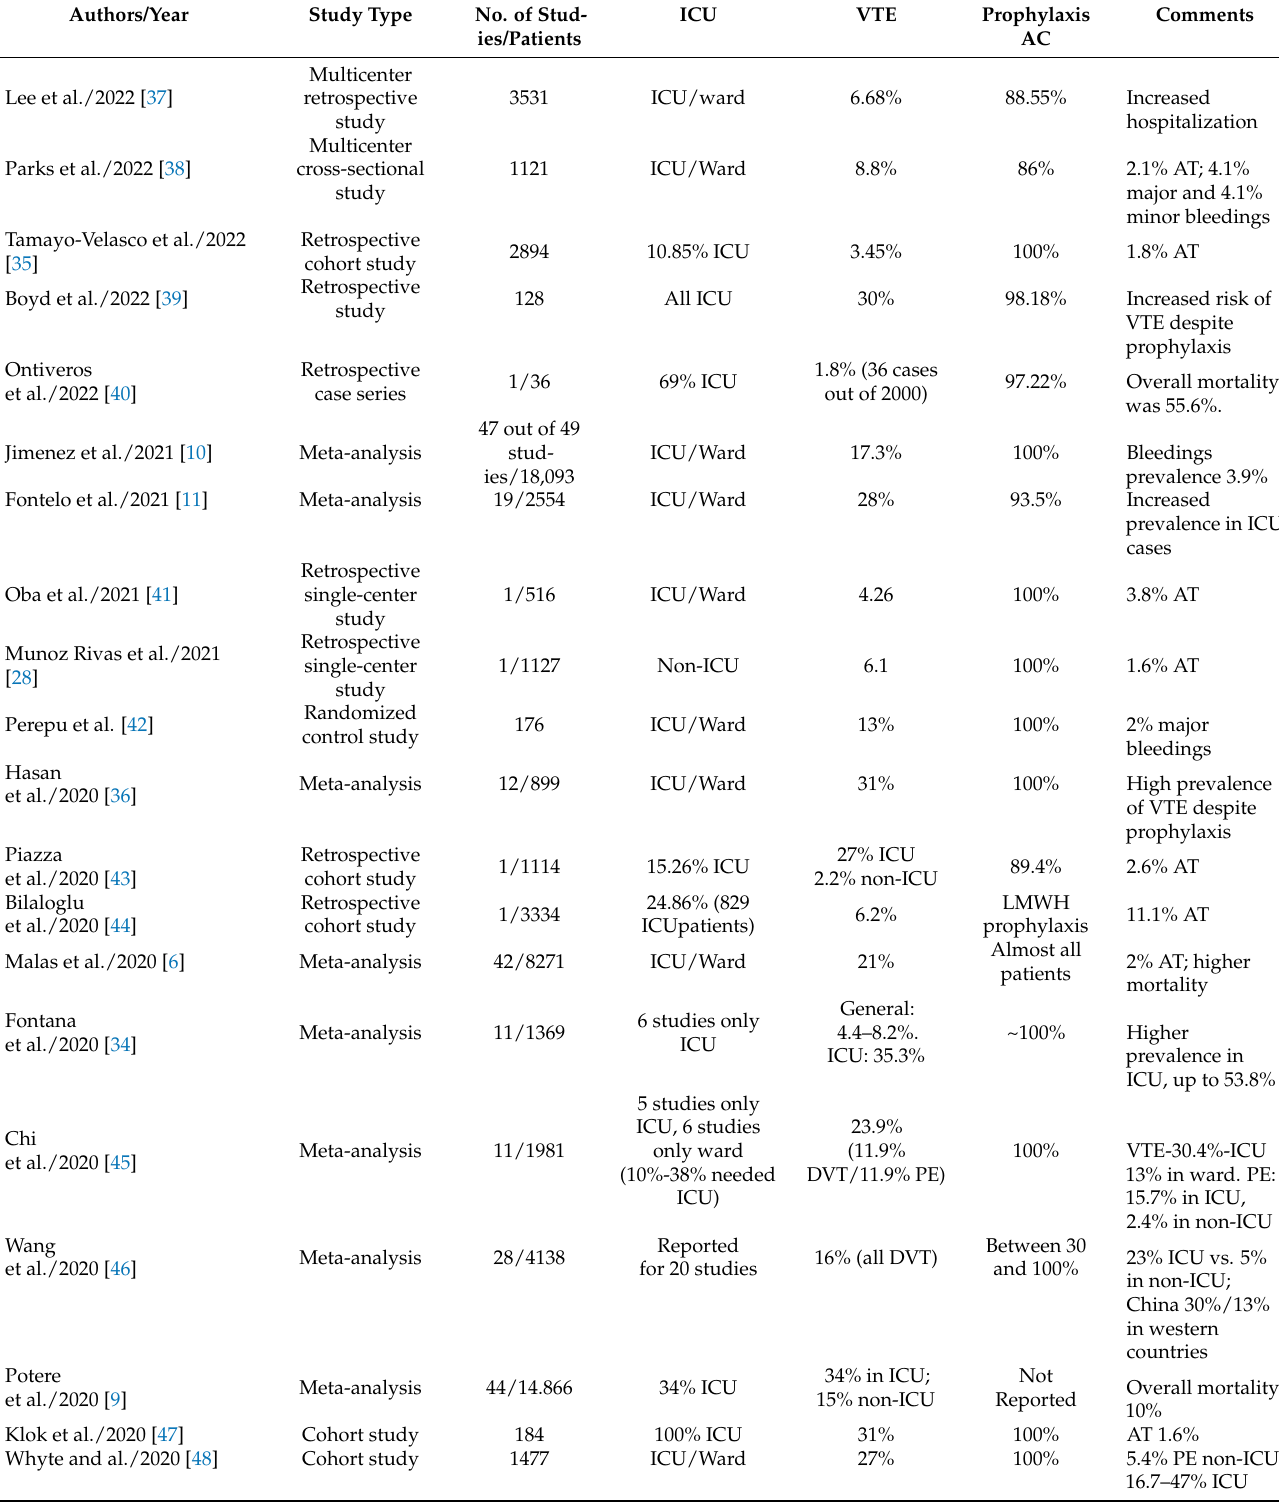
Table 1. Medical literature important studies referring to venous thrombotic events (VTE) in hospital- ized